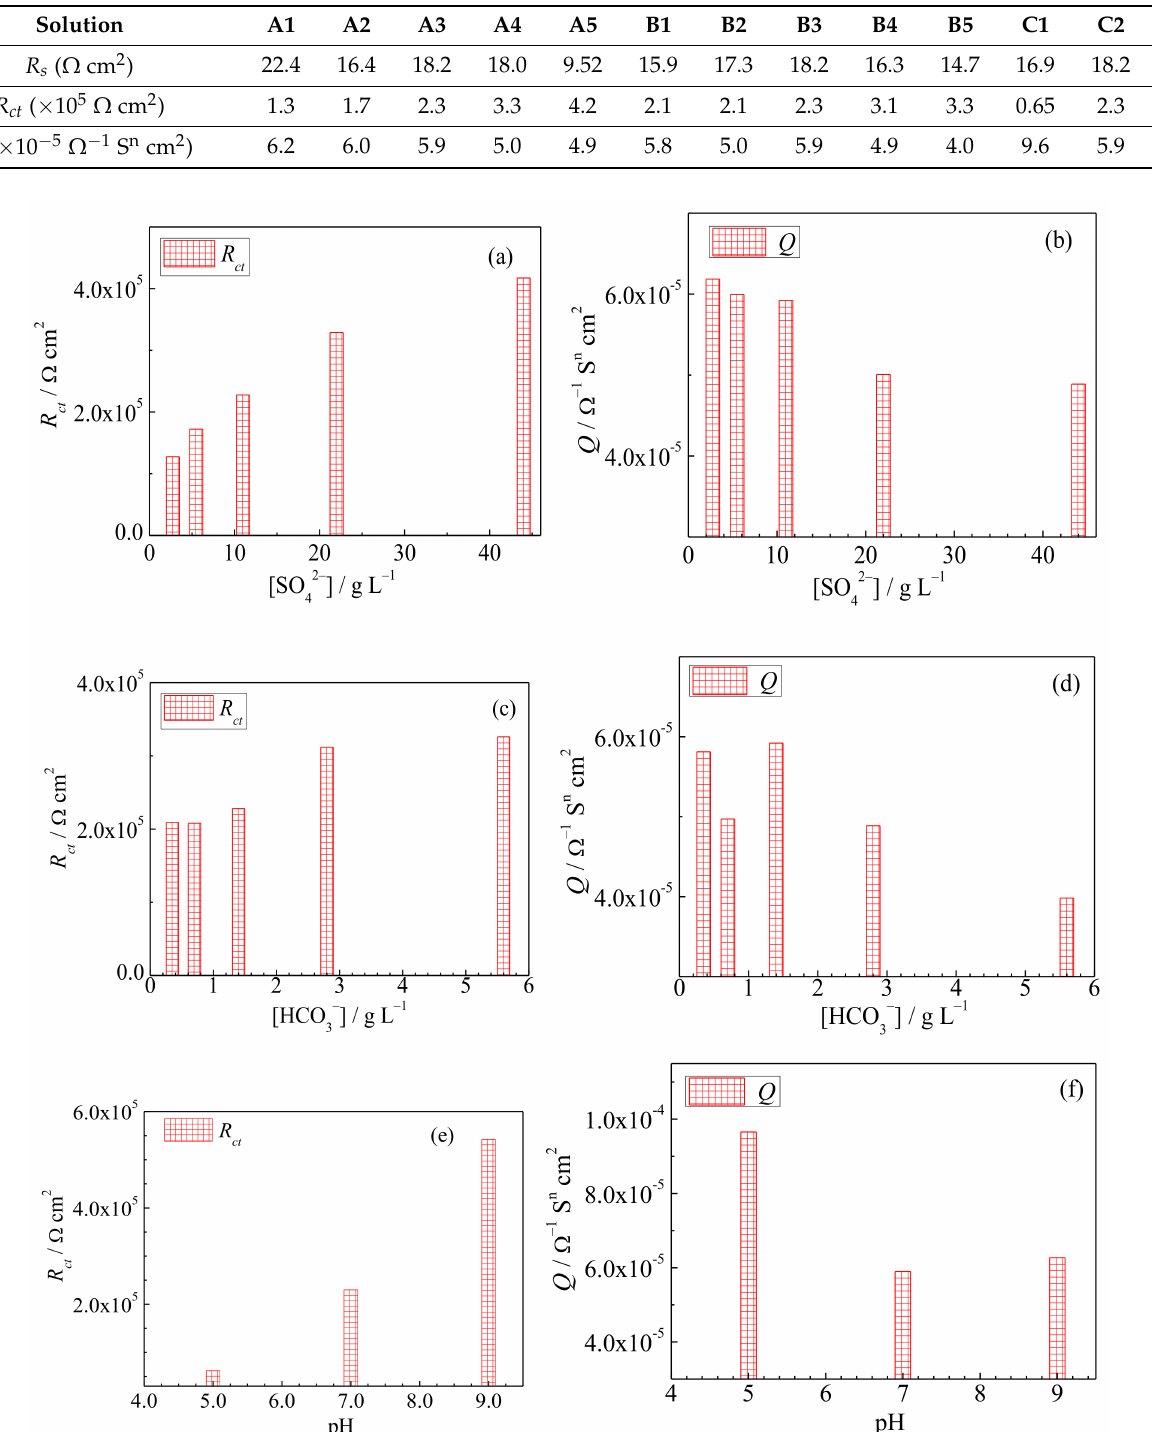
Figure 4. Fitting charge transfer resistances ( R ct ) and double-layer capacitance ( Q ) of the 201 stainless steel in the under- ground water with different contents of SO 4 2 − , HCO 3 − , as well as different pH, ( a , b ) R ct and Q in A1–A5 solutions with different concentration of SO 4 2 − , ( c , d ) R ct and Q in B1–B5 solutions with different concentration of HCO 3 − , and ( e , f ) R ct and Q in C1–C3 solutions with different pH